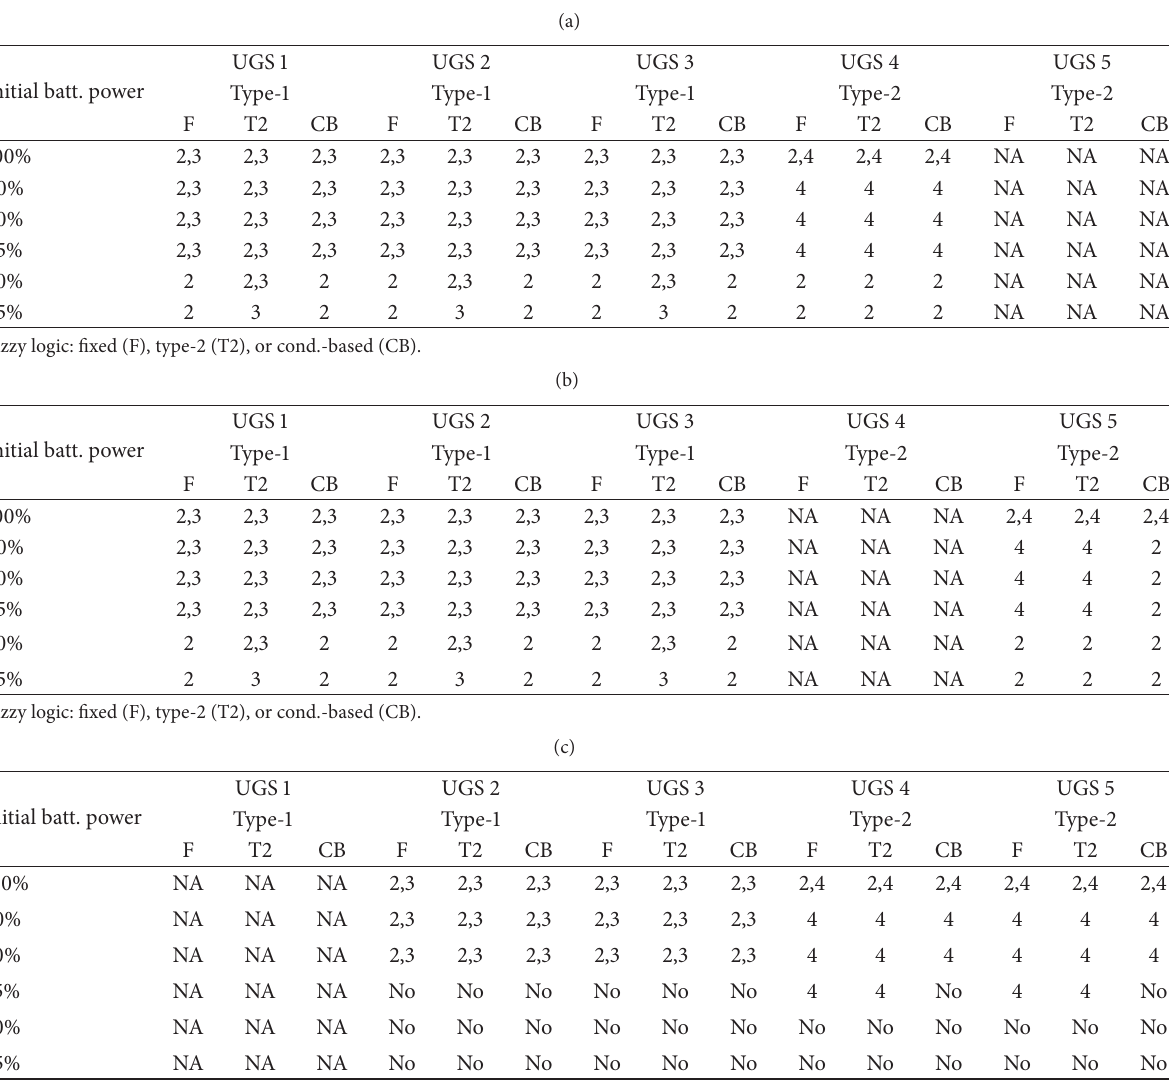
Table 5: (a) Selection of tracking sensors at UGS for fixed, type-2, and condition-based fuzzy logic: target 1. (b) Selection of tracking sensors at UGS for fixed, type-2, and condition-based fuzzy logic: target 4. (c) Selection of tracking sensors at UGS for fixed, type-2, and condition-based fuzzy logic: target